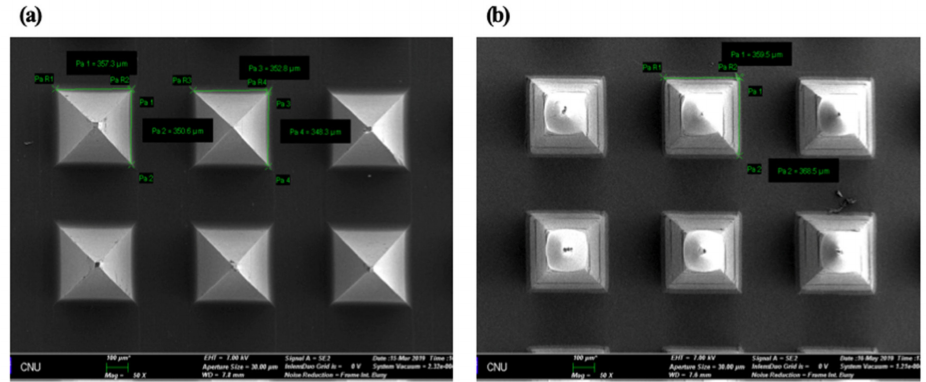
Figure 2. SEM images of blank microneedle (MN) ( a ) and HBsAg MN ( b ). Scale bar = 100 µ m.